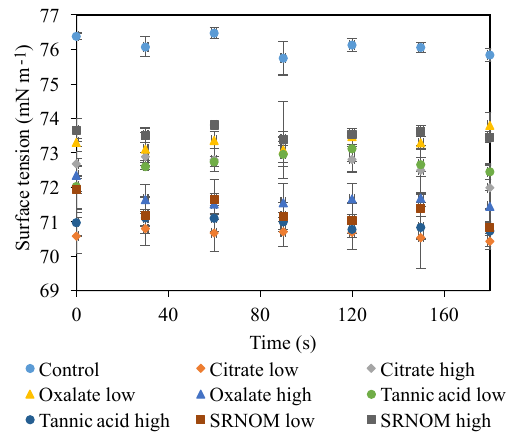
Figure 7. Dynamic surface tension of experimental solutions for control (NaCl + HNS), plant exudates (citrate and oxalate), and soil components (tannic acid and organics: Suwanee River natural or- ganic matter, SRNOM). Averages graphed, and associated error bars represent 1 standard